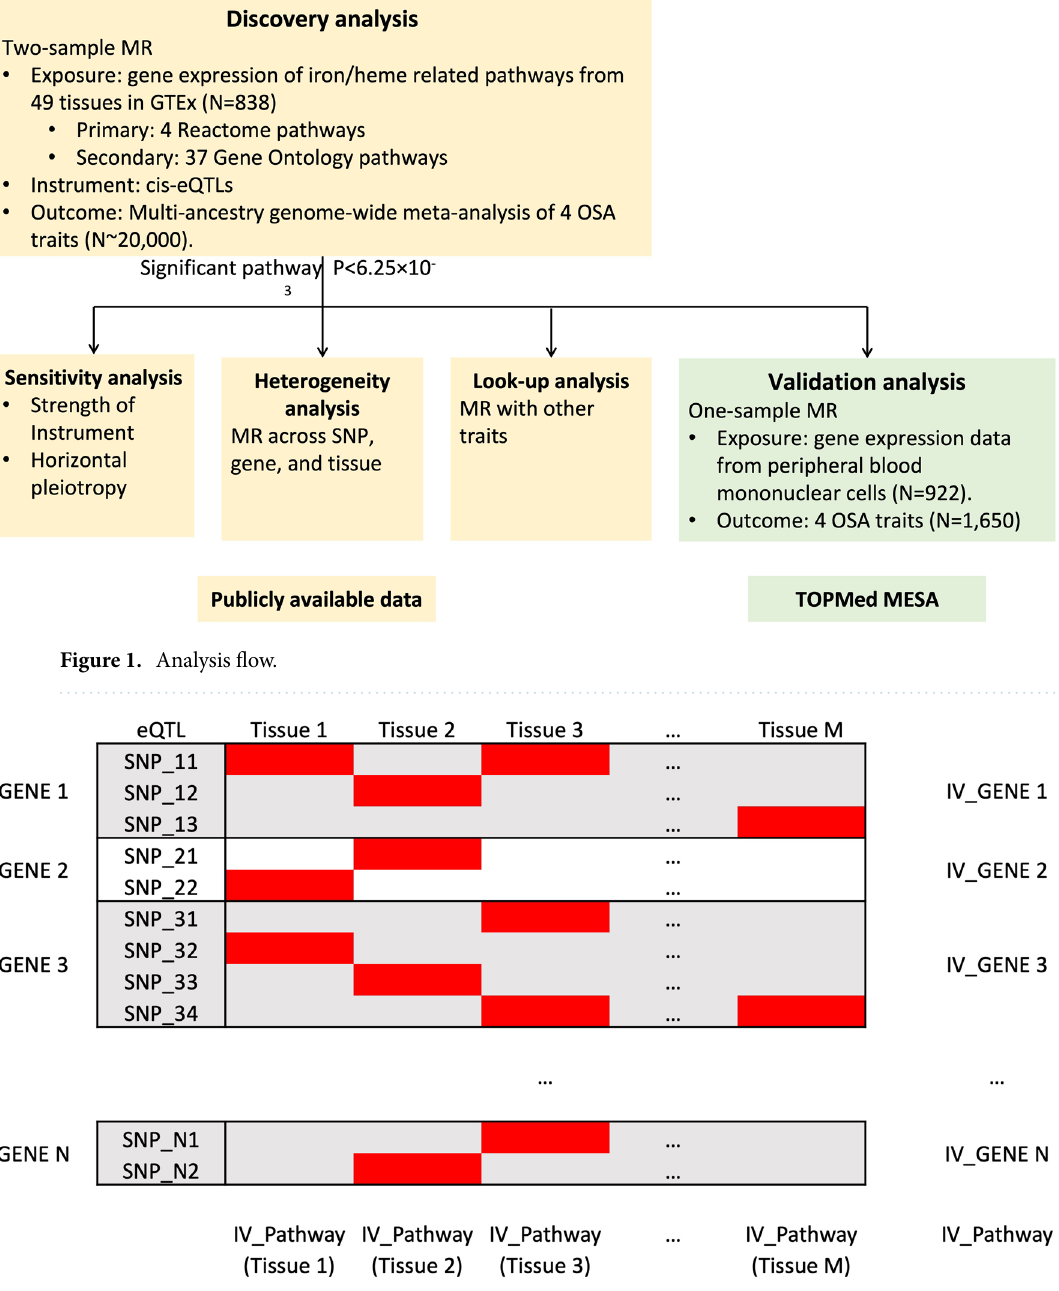
Figure 2. Illustration of the selection strategy of instrumental variables (IVs). The most significant cis-eQTLs in any tissues for a gene are highlighted in